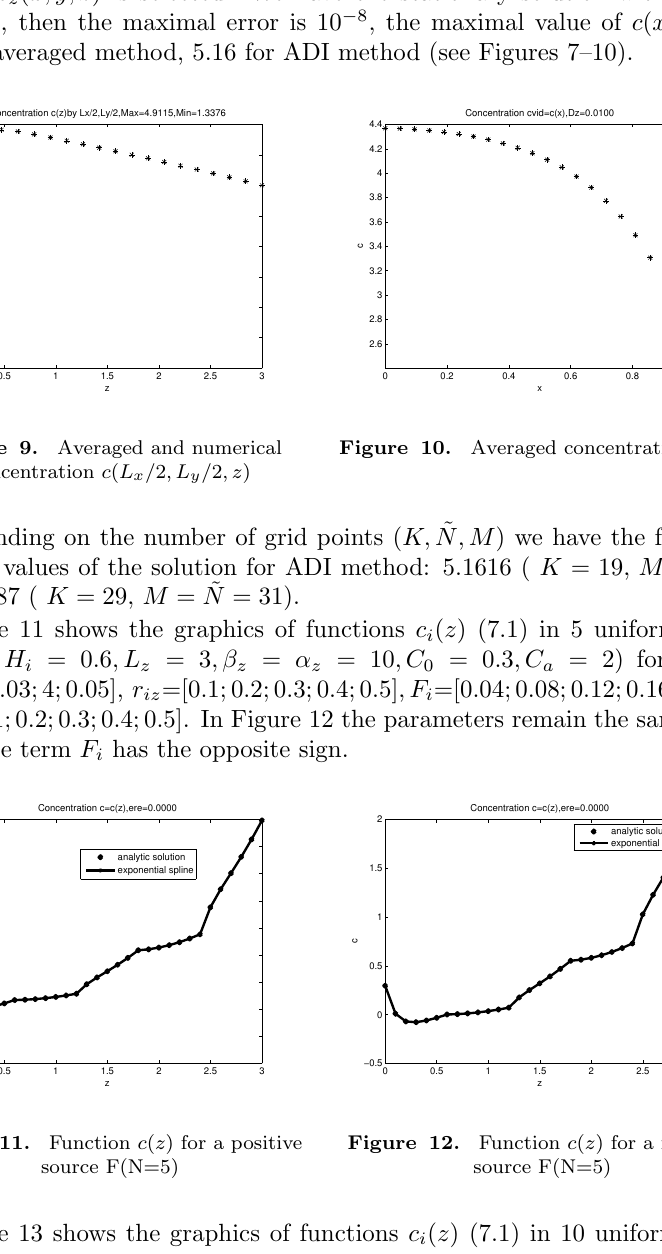
Figure 12. Function c ( z ) for a negative source